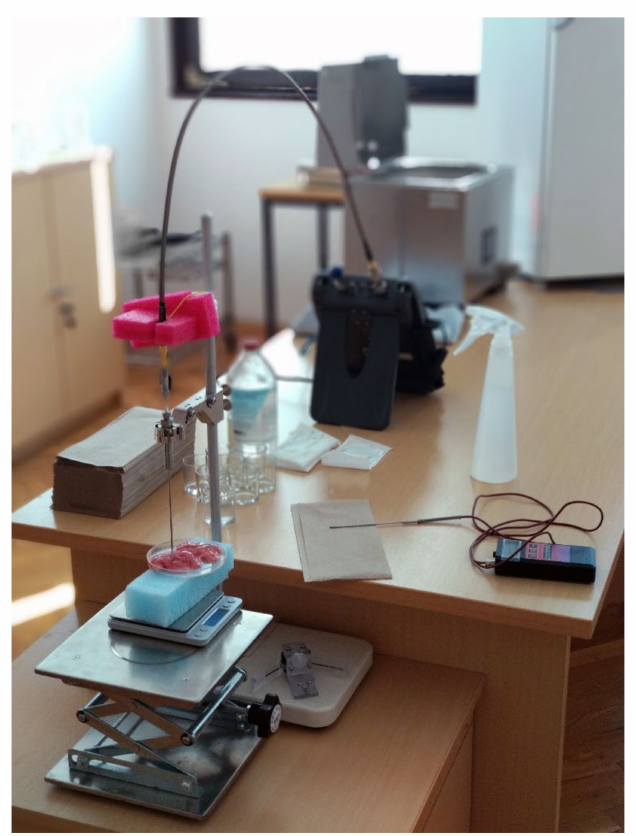
Figure 2. Measurement